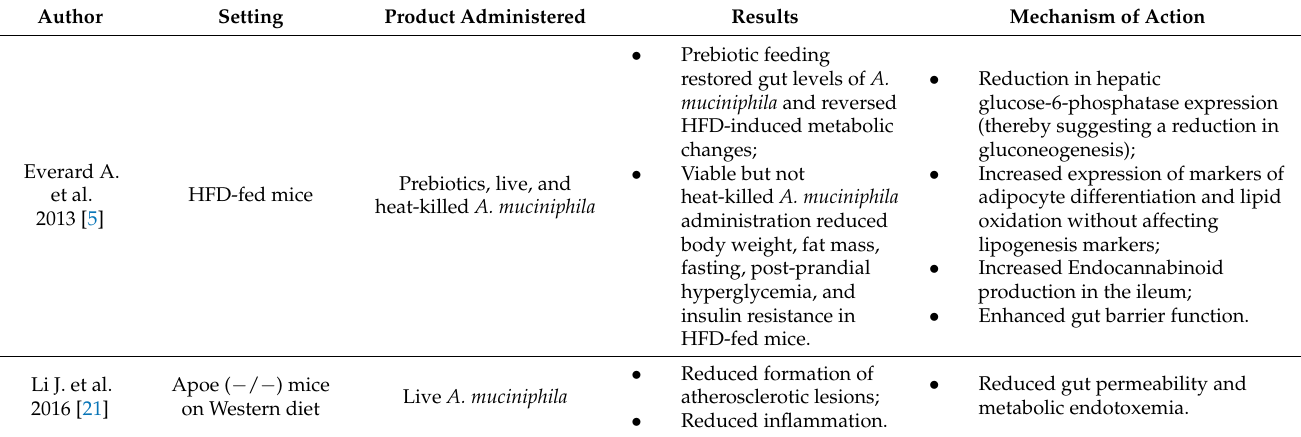
Table 2. Studies reporting on the beneficial effects of the administration of live A. muciniphila